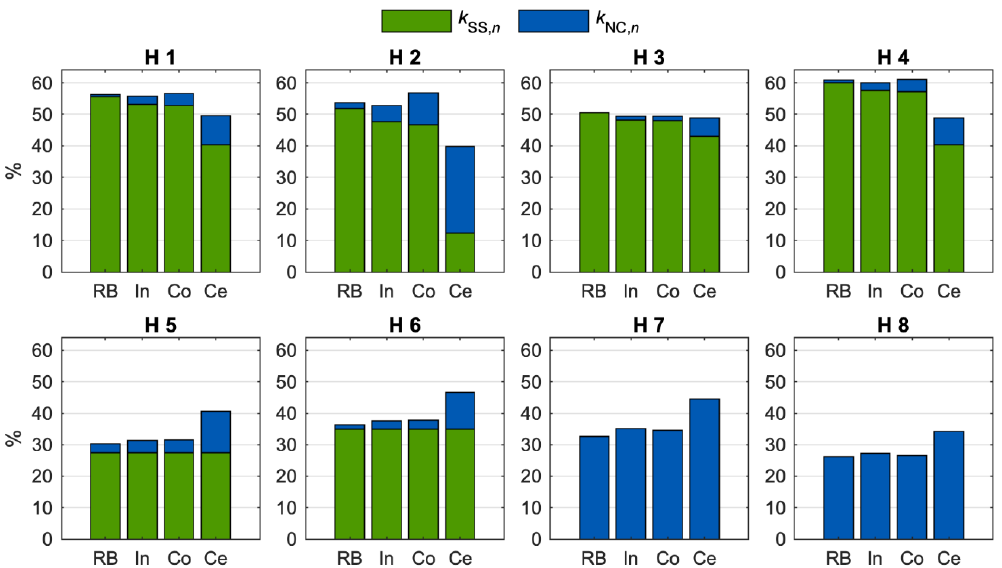
Figure 11. Individual degrees of self-sufficiency and neighborhood consumption ratios for the investigated EM concepts (In: IndOpt, Co: CoordOpt, Ce: CentralOpt, H: household).